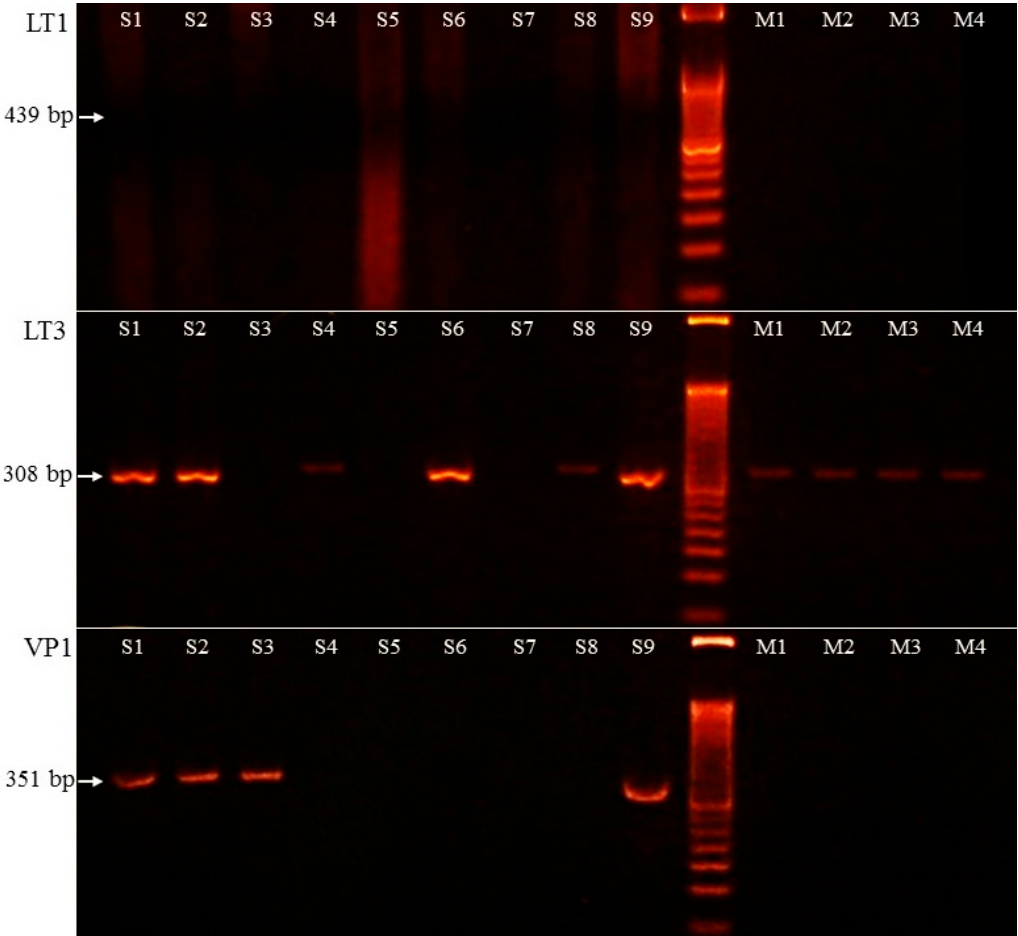
Figure 2. PCR amplification results of Merkel cell polyomavirus LT1 (large T1), LT3 (large T3), and VP1 (viral capsid protein 1) sequence. S1–S9: Merkel cell carcinoma samples, M1–M4: melanoma (LT1), 308 bp (LT3), and 351 bp (VP1). Table 3. Molecular genetic NGS findings of MCC and melanoma samples. The clinical significance of gene variants was checked in the COSMIC database. The ID of nucleotide and amino acid changes were included in the table. S1–S9: Merkel cell carcinoma samples, M1–M3: melanoma samples. The PCR results of MCPyV status are presented in parentheses.